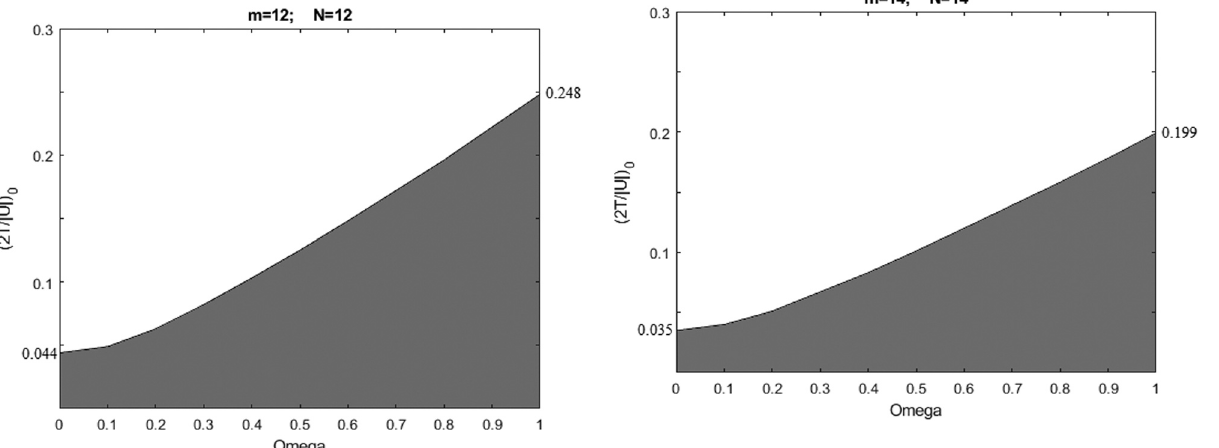
Figure 5: Critical dependence of the virial ratio on the rotation parameter for m 14 = ; N 14 =